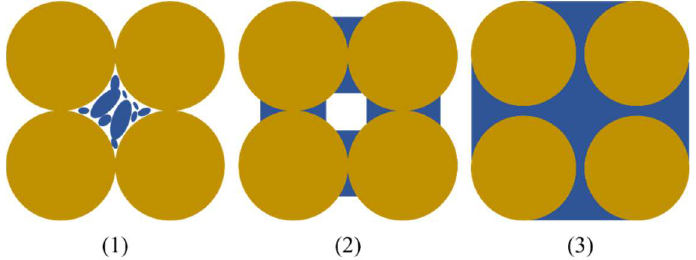
Figure 1. Hydrate occurrence state: ( 1 ) pore filling; ( 2 ) load bearing; ( 3 ) cementation. On the basis of the original soil strength test apparatuses, a low-temperature refrig- eration chamber and a high-pressure gas inlet and outlet system were added to realize in situ MHBS synthesis [20]. A series of experiments revealed that the mechanical strength of synthetic MHBS was similar to that of natural MHBS [16,21–23]. Hyodo et al. reported that higher hydrate saturation, lower temperature, and larger pore pressure increased the peak strength of MHBS [24]. Yun et al. used tetrahydrofuran hydrate to carry out a series of triaxial compression tests. Their research reflected that the mechanical properties of tetrahydrofuran hydrate sediment mainly depended on the skeleton particles when the hydrate saturation was low. When the hydrate saturation was high, the hydrate cemented between skeleton particles [25]. The larger the particle size of the sediment, the lower the pore pressure. Hydrate exists in sediment with a large skeleton particle size [26]. Song et al. confirmed that an increase in confining pressure and strain rate, and a decrease of tem- perature led to the enhancement of shear strength [27]. Miyazaki et al. found that the co- hesion of MHBS was related to hydrate saturation, while the internal friction angle was